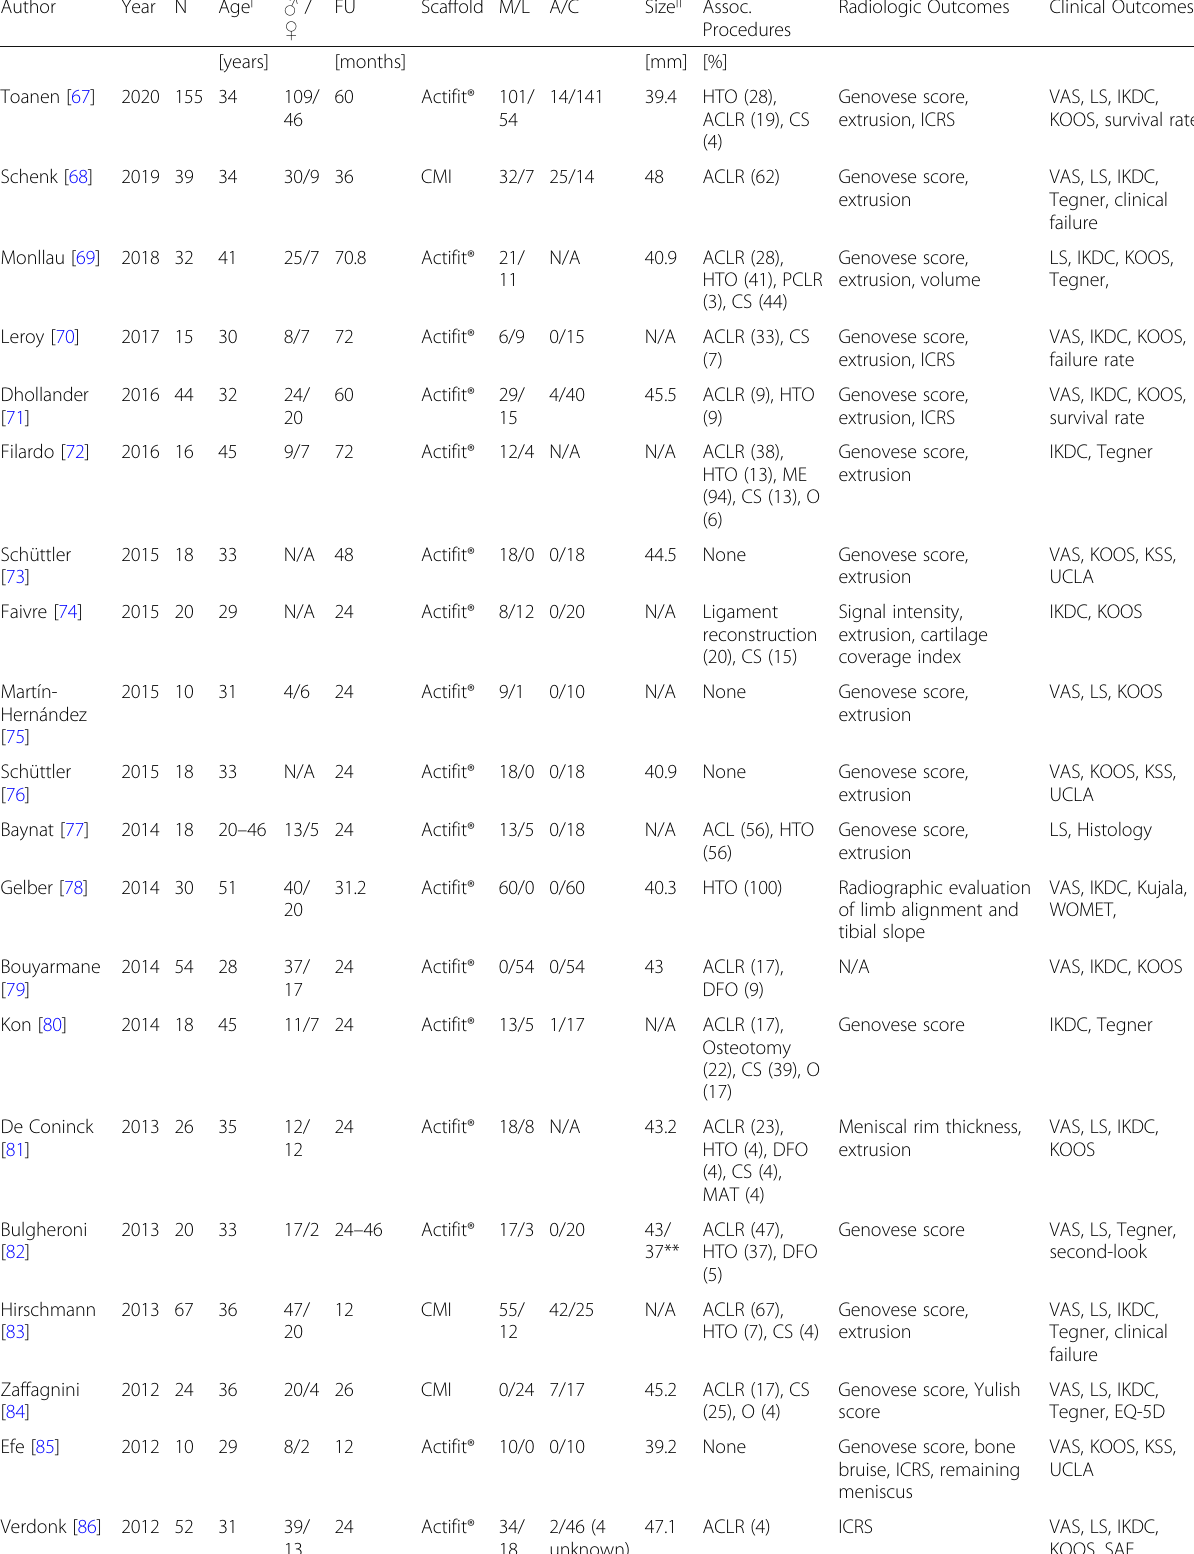
Table 1 Synopsis of clinical studies on scaffold-based meniscal substitutes (chronological order)